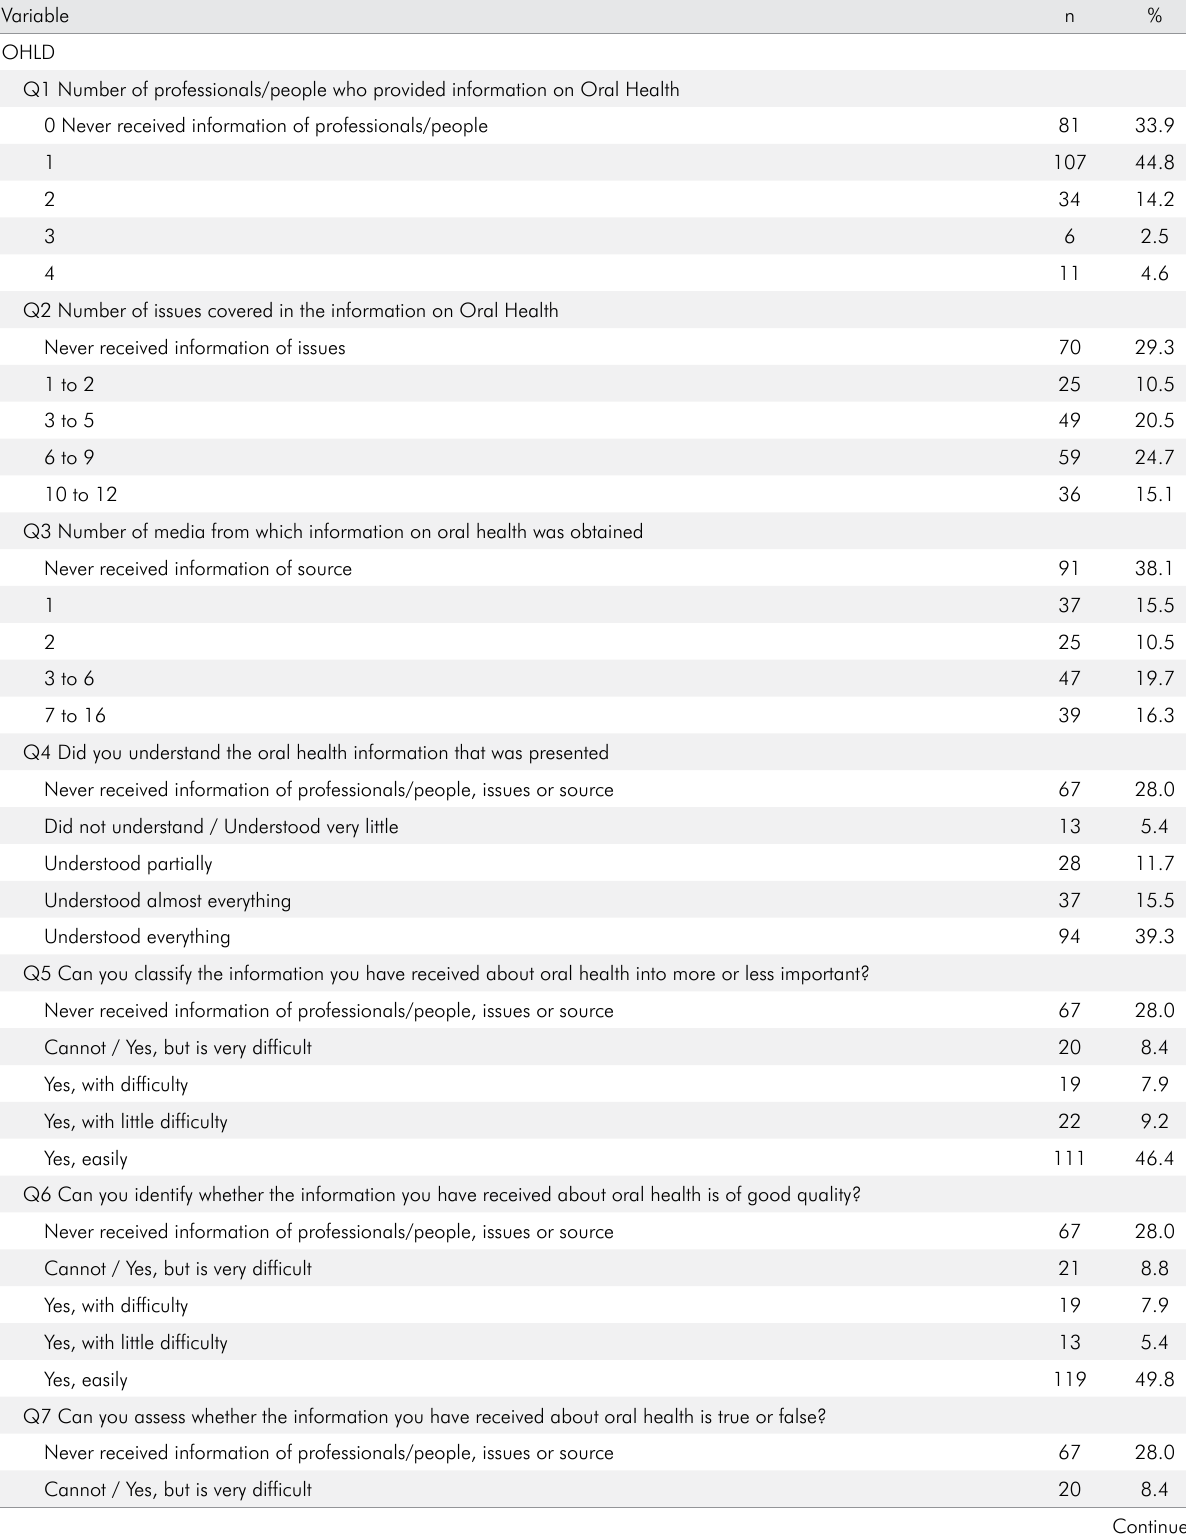
Table 1. Description of the responses to each item of the instrument among individuals with diabetes. Variable n %